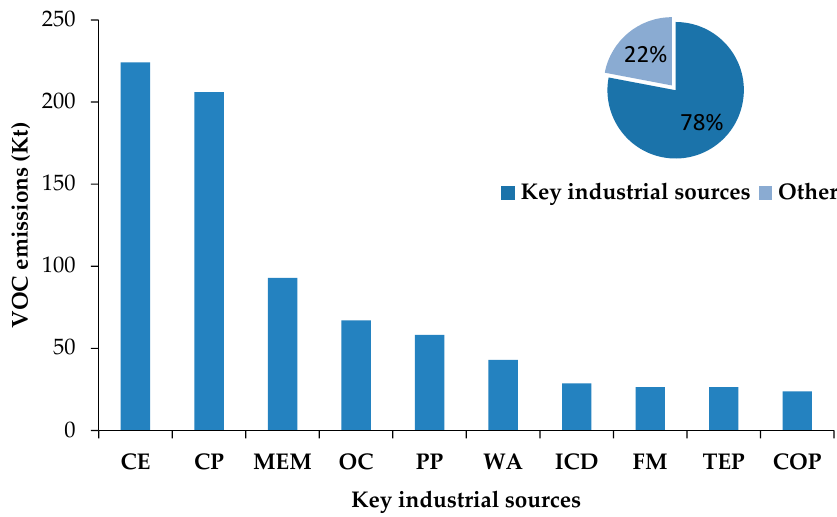
Figure 4. VOC emissions of key industrial sources (CE: chemical medicine; CP: coke production; MEM: mechanical equipment manufacturing; OC: organic chemical; PP: packaging and printing; WA: wood adhesives; ICD: industrial and construction dyes; FM: furniture manufacturing; TEP: transportation equipment manufacturing; COP: crude oil processing). 107